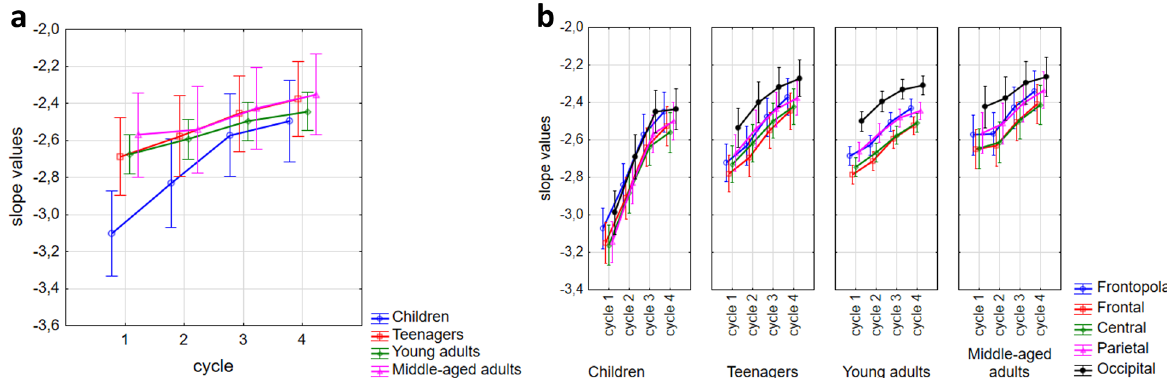
Figure 2. NREM sleep EEG spectral slopes as functions of sleep cycles, age and recording sites. ( a ) Representation of cycle × age group interaction in spectral slope values. ( b ) Depiction of cycle × region × age group interaction in spectral slope values. Dots are group mean values, whereas vertical bars denote 95% confidence intervals.